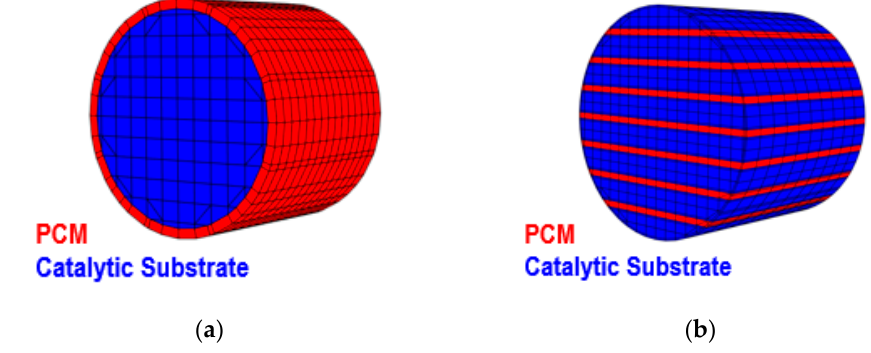
Figure 15. ( a ) External PCM configuration; ( b ) Internal PCM configuration.